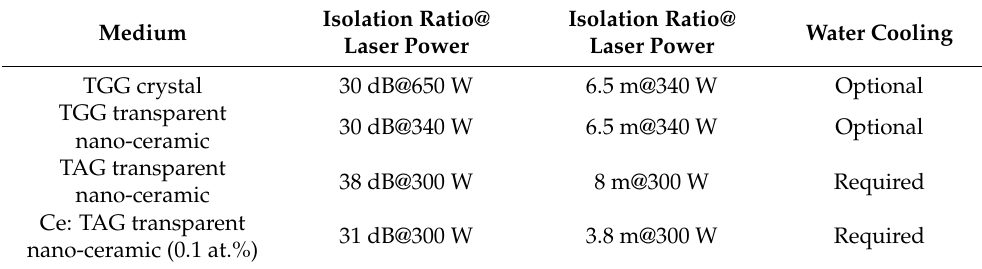
Comparison of characteristics of Faraday isolators with different magneto-optical media [38,56]. Reprinted with permission from Ref. [38]. Copyright 2018, copyright CNKI. Reprinted with permission from Ref. [56]. Copyright 2017, copyright